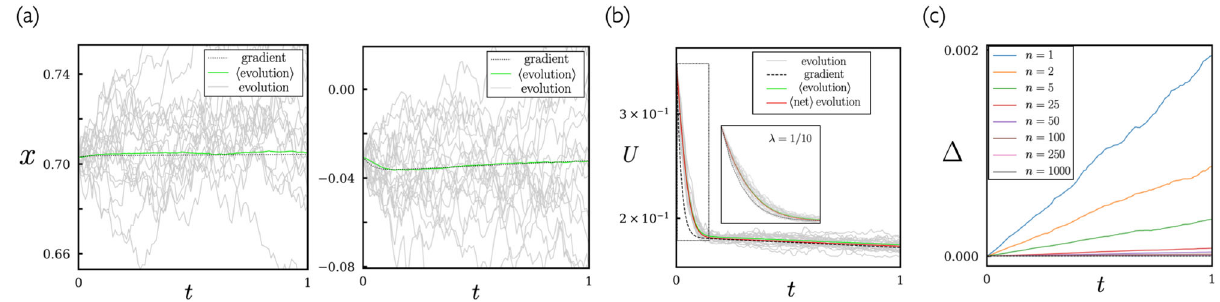
Fig. 6 Illustration of the neuroevolution-gradient descent correspondence for the case of fi nite β . Panel a shows two parameters of the network, panel b shows the loss, and panel c shows the parameter Δ , Eq. (15), a measure of the difference between the average network produced by neuroevolution and the network produced by a function of n , the number of trajectories included in the average. If correspondence holds, this quantity should vanish in the limit of large n ; the observed trend is consistent with this behavior.